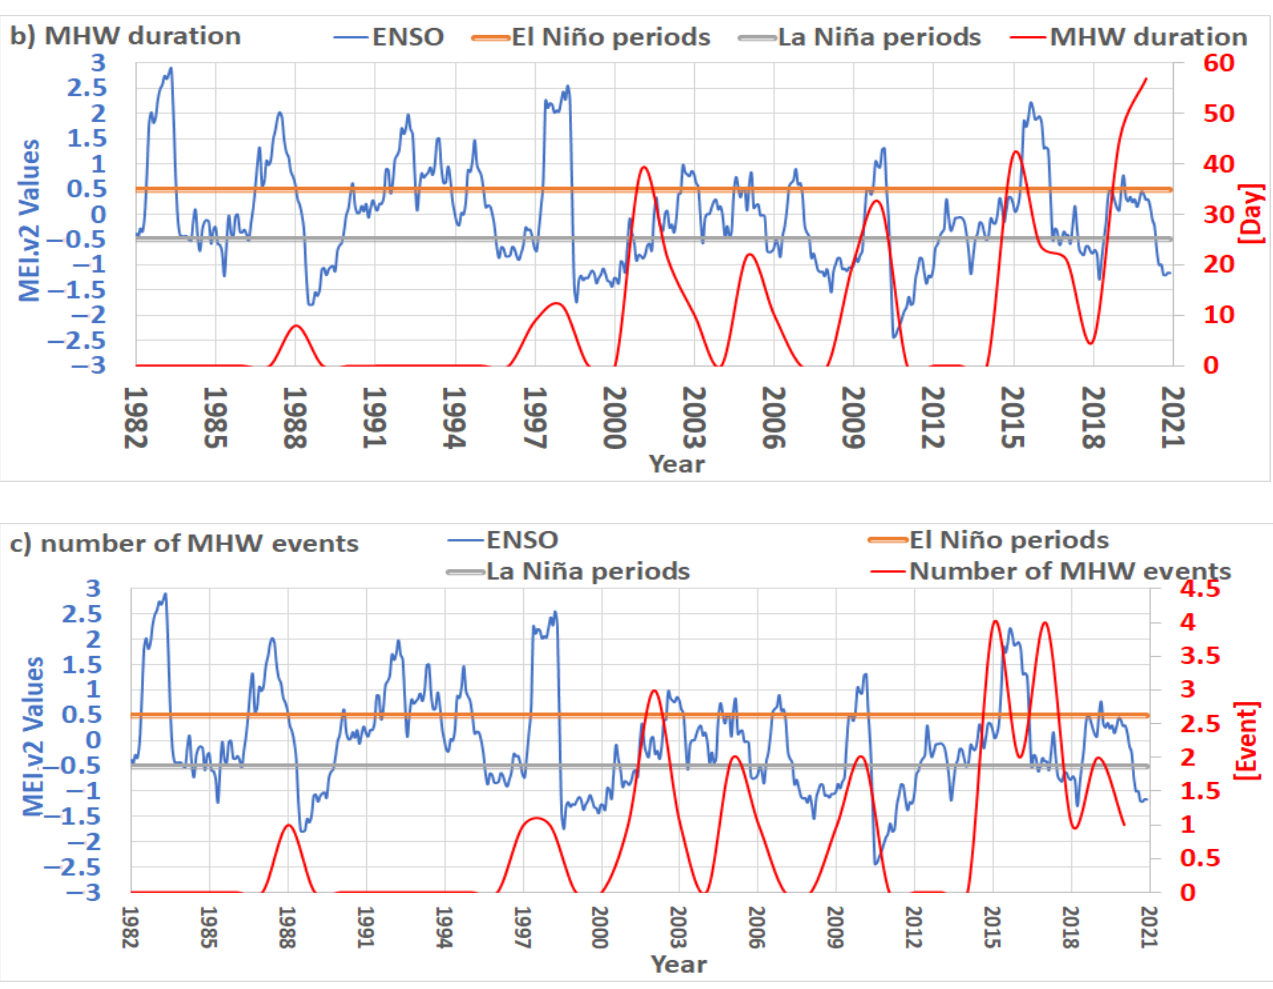
Figure 6. Annual time series of the bi-monthly multivariate El Niño/Southern Oscillation (ENSO) index (MEI.v2) over 1982–2020 are shown in primary axis. Moreover, the lower (higher) limit of El Niño (La Niña) periods is shown in orange (gray) color. In the secondary axis and in red color, intensity, duration and frequency were shown in ( a – c ), respectively.